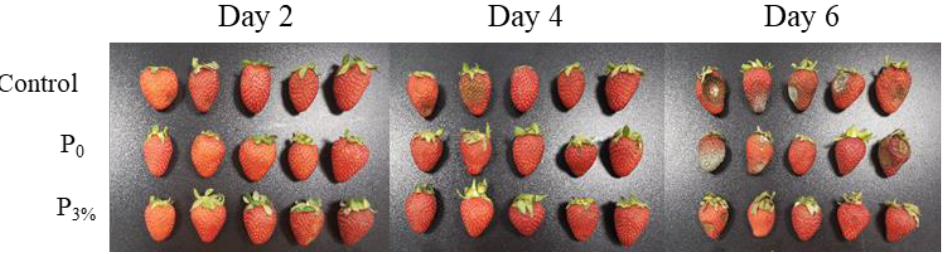
Figure 11. Appearance of strawberries coated with different treatment groups.